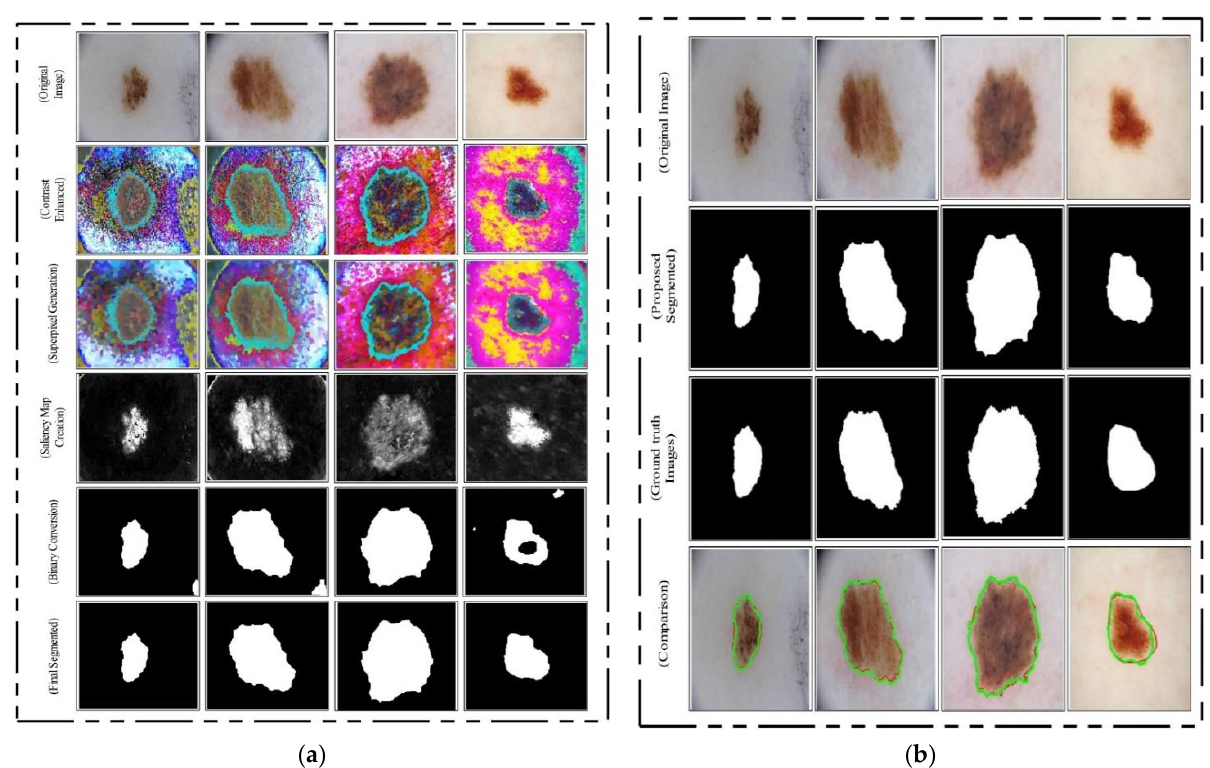
Figure 10. Proposed skin lesion segmentation results. ( a ) Intermediate segmentation results, ( b ) segmentation results compared with ground truth images.